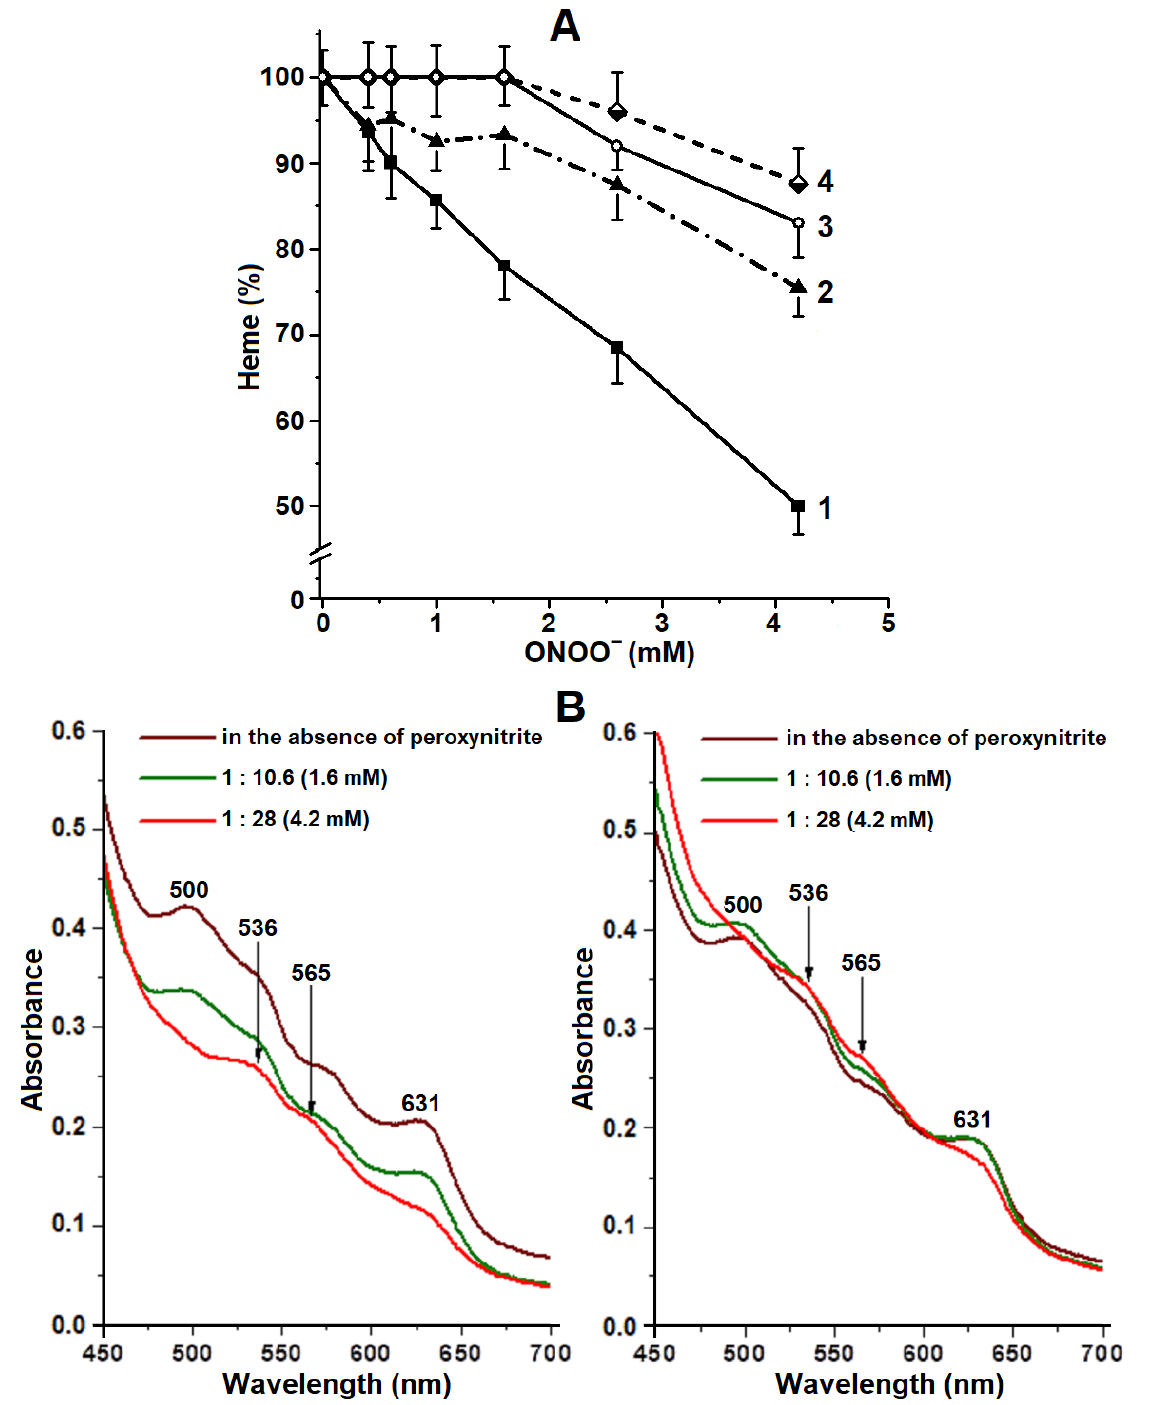
Figure 4. ( A )—destruction of the heme group of methemoglobin under the impact of peroxynitrite. Curves 1 and 3—metHb, curves 2 and 4—Hb-DNICs, curves 3 and 4—with diethylenetriaminepentaacetic acid (DTPA). The composition of the reaction medium, including peroxynitrite concentration, is the same as in the legend to Figure 3. ( B )—Changes in the state of the heme group in Hb-DNICs during the oxidation by peroxynitrite. Left—metHb,